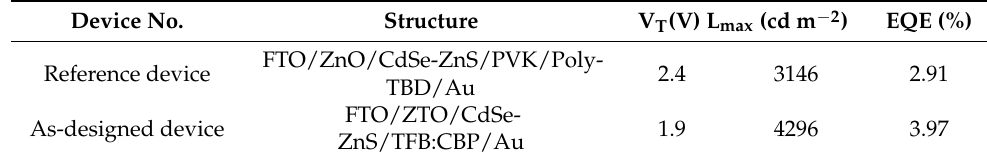
Figure 5. Comparisons results; ( a ) current density vs. voltage (V); ( b ) luminance vs. V; ( c ) current efficiency vs. V; ( d ) external quantum efficiency vs. V. Table 1. Comparisons of the characteristics of the reference device and as-designed